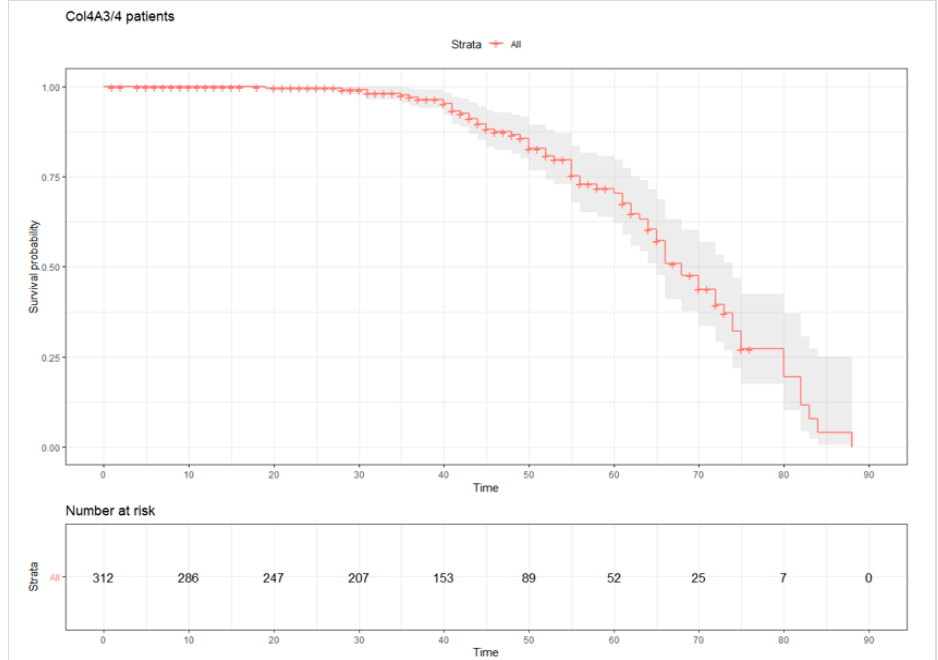
Figure 2. The cumulative probability of adverse renal events (ESKD, CKD, dialysis, renal transplant, or death due to renal failure). This graph represents the risk of renal failure through the occurrence of different renal events (ESKD, CKD, dialysis, renal transplant, or death due to renal failure) in patients with heterozygous deleterious mutations in the COL4A3 and COL4A4 genes. Twenty-three percent of all patients suffered some kind of renal event.